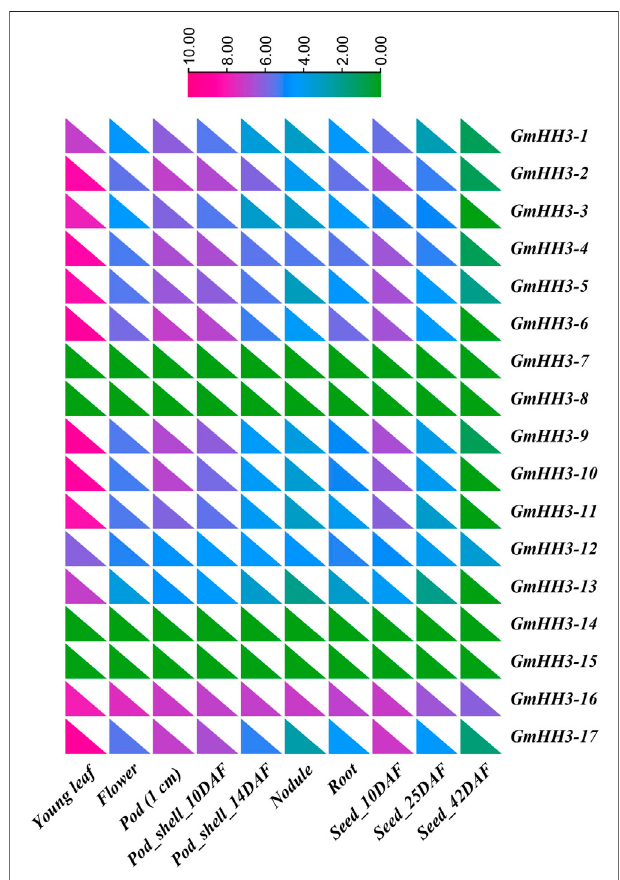
FIGURE 6 | Tissue-speci fi c expression pro fi ling based on FPKM values. DAF, days after